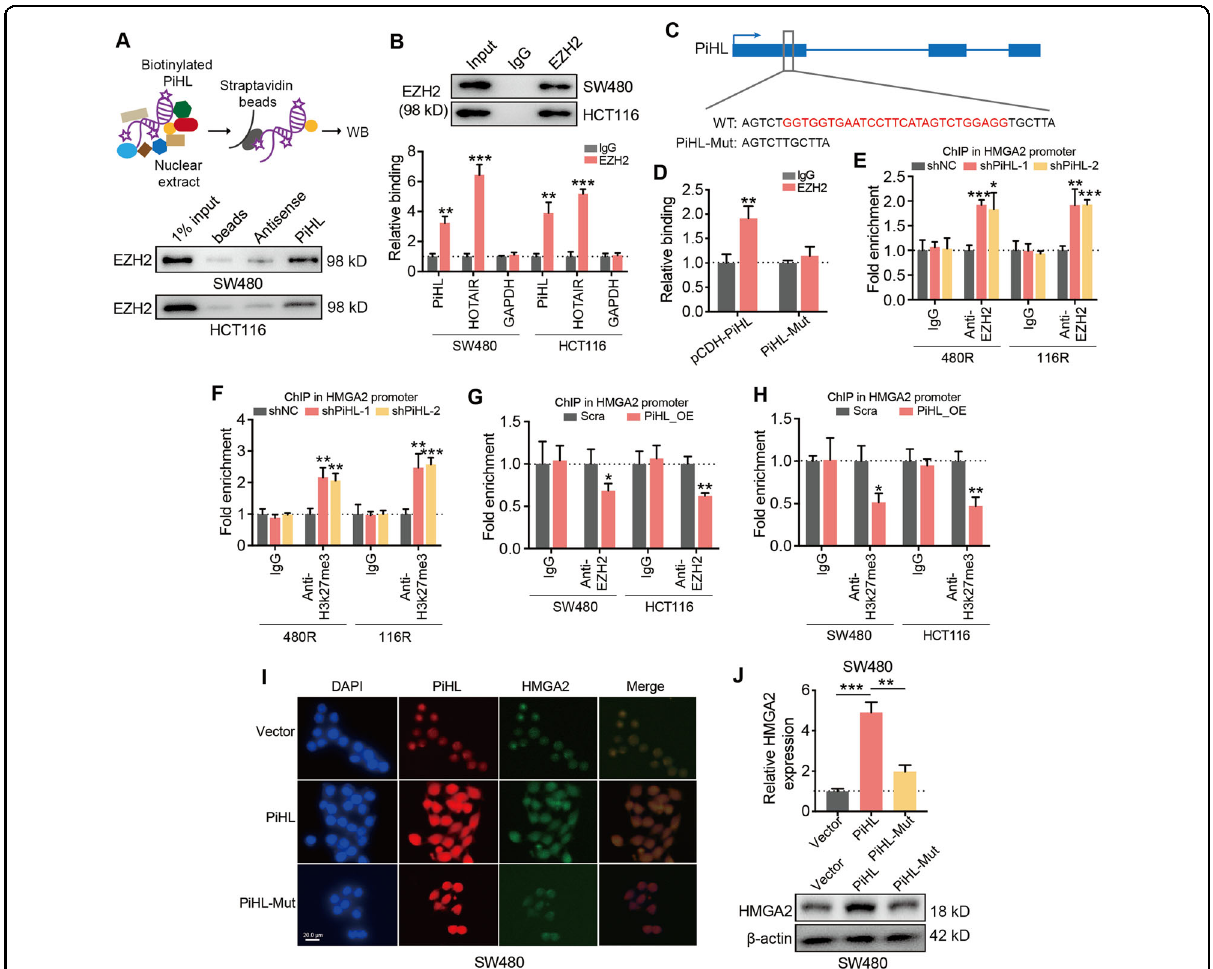
Fig. 5 PiHL regulates HMGA2 via interaction with EZH2. A Experimental design for pull-down assays (top) and immunoblots of EZH2 proteins retrieved by in vitro-transcribed biotinylated PiHL from cell nuclear extracts (bottom). Antisense PiHL and beads were used as negative controls. B Cell nuclear lysates were immunoprecipitated with anti-EZH2 antibodies, Aliquots of cell lysates (10% of input) and IgG or EZH2 immunoprecipitates were separated by SDS-PAGE, and the speci fi c immunoprecipitation of EZH2 was con fi rmed by Western blot (WB) (top). The complexes were analyzed for the presence of PiHL, HOTAIR (EZH2-binding positive control), or GAPDH (negative control) by qRT-PCR (bottom). Signals were normalized to actin mRNA. C Representation of the WT and mutated (PiHL-Mut) PiHL sequences used for immunoprecipitations (IP) with anti-EZH2. PiHL-Mut contains a deletion of the G-quadruple sequence, Fig. S4A. D The bar graph shows the relative amount of PiHL after anti-EZH2 IP using lysates of cells transfected with either pCDH-PiHL or PiHL-Mut. E , F ChIP assay using EZH2 ( E ) and H3K27me3 ( F ) speci fi c antibodies was undertaken in PiHL stably knockdown Oxa-resistant CRC cells to detect the effects of PiHL on EZH2 location and H3K27me3 level at HMGA2 promoter. G , H ChIP assay using EZH2 ( G ) and H3K27me3 ( H ) speci fi c antibodies were undertaken in PiHL stably overexpressed CRC cells to detect the effects of PiHL on EZH2 location and H3K27me3 level at HMGA2 promoter. I RNA FISH to visualize PiHL (red) and FITC staining of HMGA2 (green) in SW480 cells transfected with pCDH (Vector, Upper), pCDH-PiHL (PiHL, Middle), or PiHL-Mut (Lower), (Scale bar, 20 μ m). Nuclei were stained with 4 ′ ,6- diamidino-2- phenylindole (DAPI) (blue). J HMGA2 RNA (top) and protein (bottom) levels were measured in SW480 cells transfected with pCDH (Vector), pCDH- PiHL (PiHL), or PiHL-Mut by qRT-PCR and immunoblot, respectively. Data represent the mean ± SD from three independent experiments. * P < 0.05, ** P < 0.01, *** P <